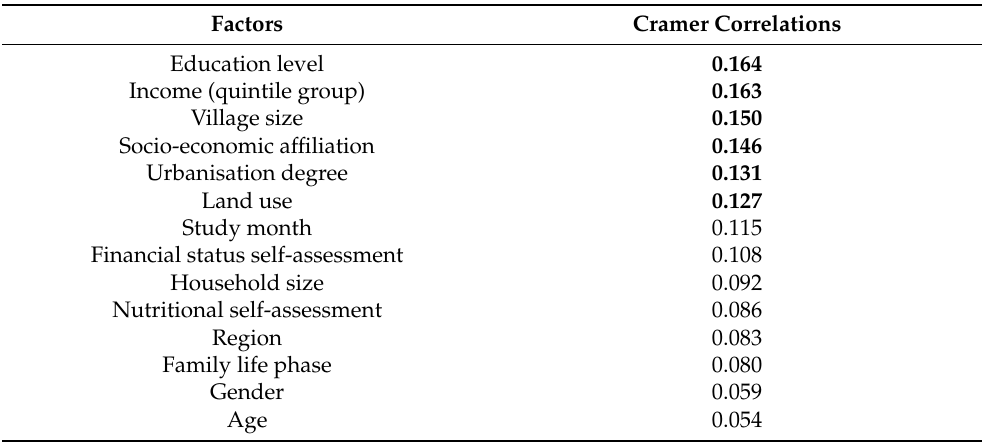
The most influential factors are highlighted in